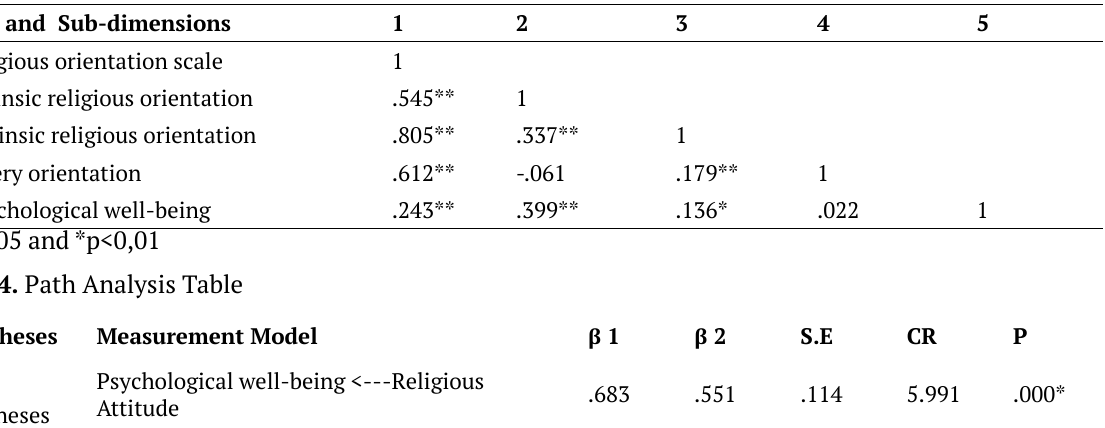
Table 3. Correlation Analysis for Scales and Sub-dimensions Scales and Sub-dimensions